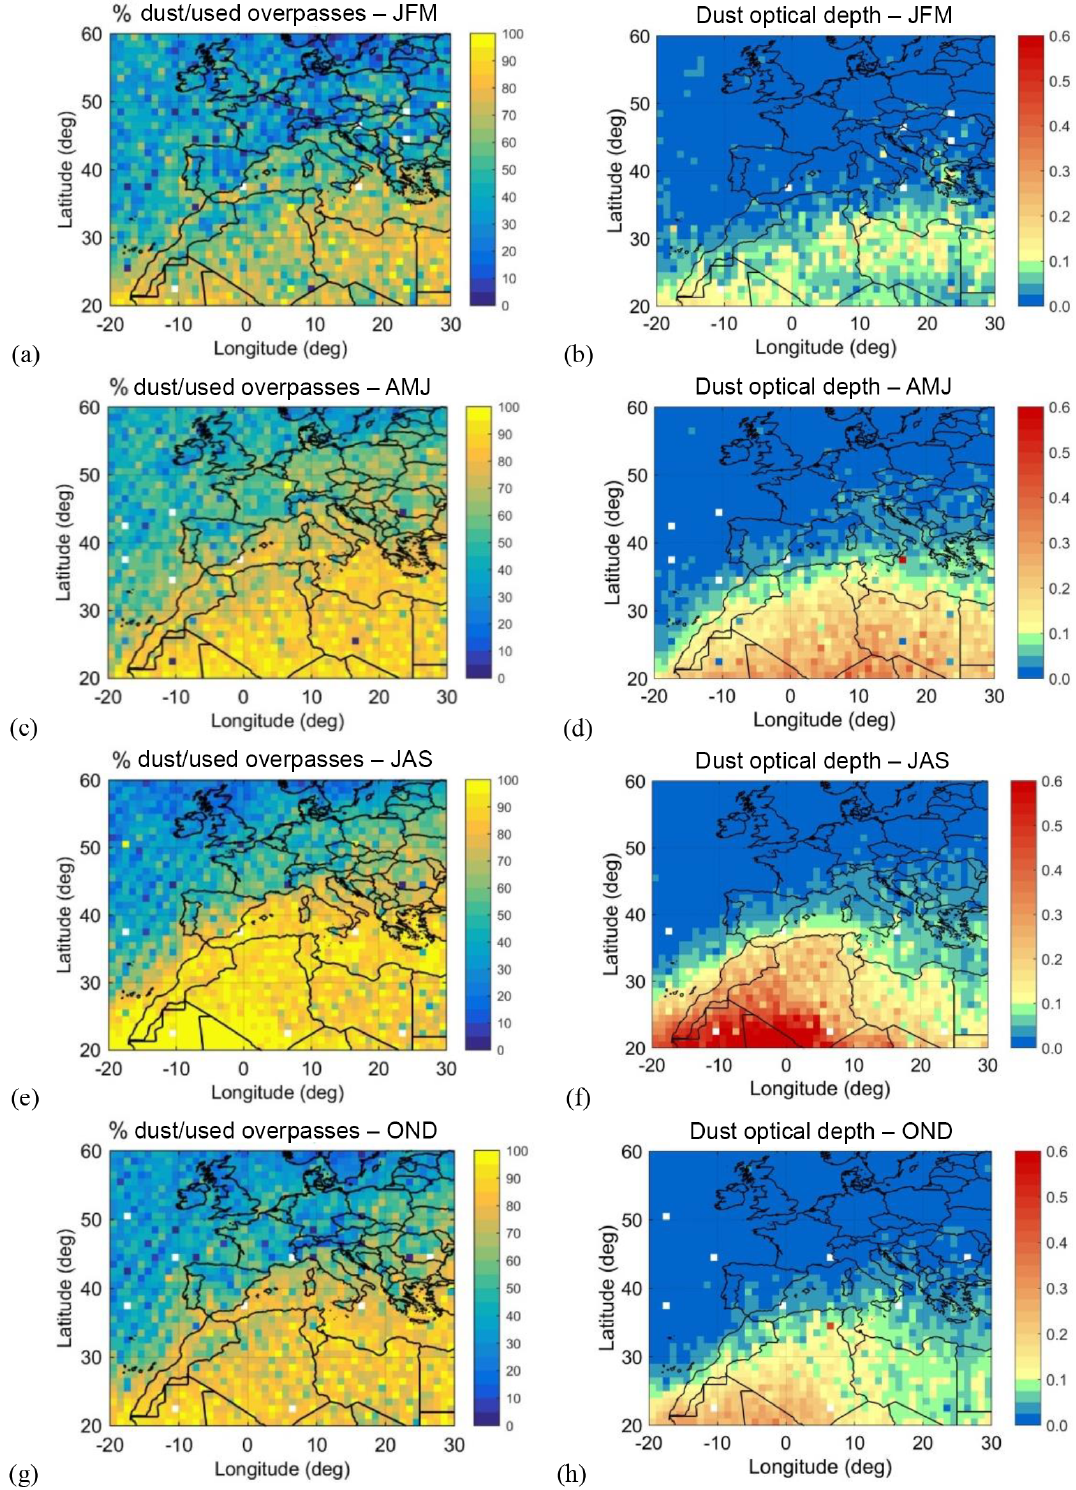
Figure 1. Geographical distribution of the seasonal dust occurrences (a, c, e, d) and the mean DOD values (b, d, f, h) for the 3-month averages: January–March (a, b) , April–June (c, d) , July–September (e, f) , and October–November (g, h) , and the domain between 20 ◦ W– 30 ◦ E and 20–60 ◦ N for the period 2007–2015, measured with the CALIPSO climatological dust